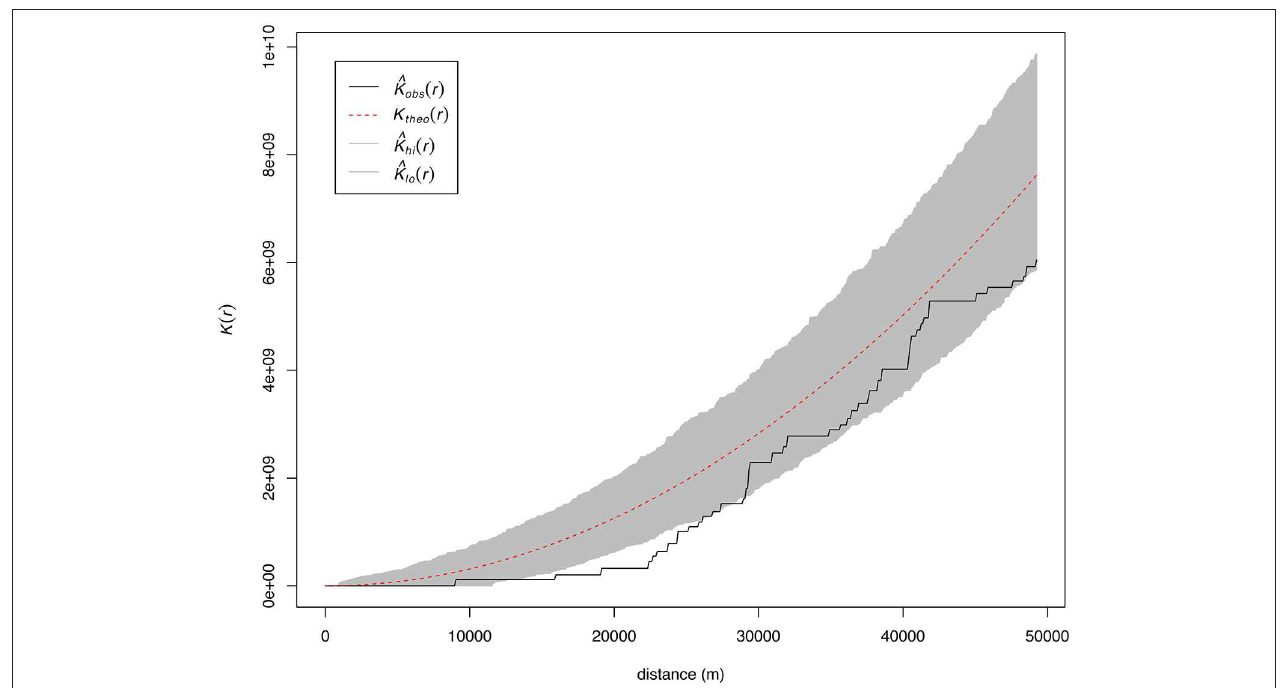
FIGURE 15 | Multi-scalar point pattern analysis of the 25 major centres to assess clustering or evenness of spatial distribution. The black solid line describes the observed patterns. The grey envelope represents randomly generated points with a 95% confidence interval. The red dotted curve indicates the theoretical complete spatial